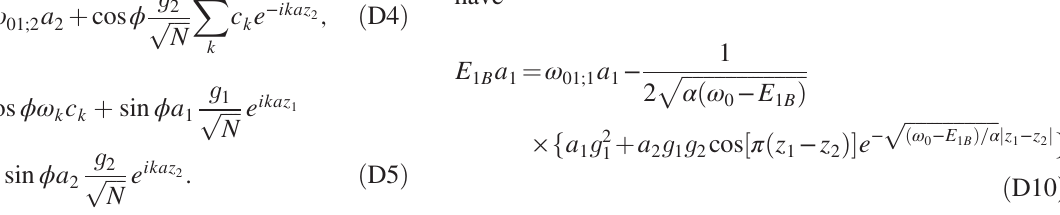
ffiffiffiffiffiffiffiffiffiffiffiffiffiffiffiffiffiffiffiffiffiffiffi α ð ω − E 0 1 B Þ